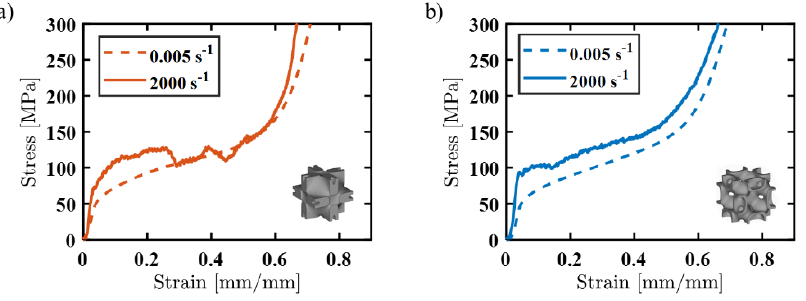
Fig. 5 . Quasi-static and dynamic stress-strain response of a) Neovius and b) FRD.